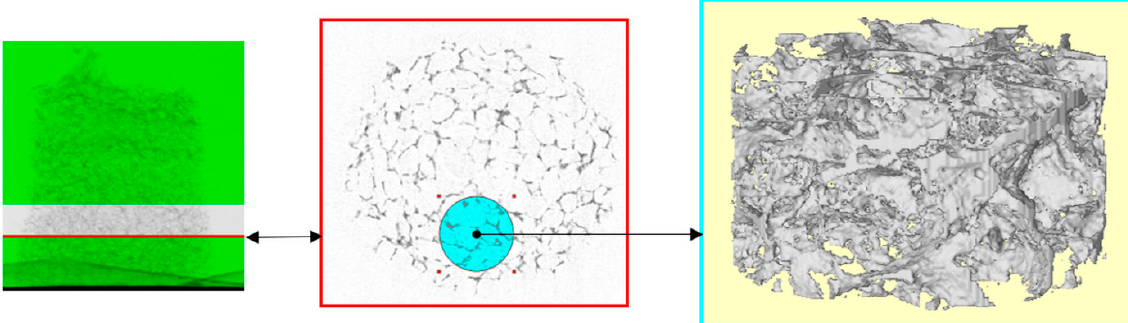
Figure 2. Graphical representation of the ROI—circular cyan area on a slice of the SSF sample and the corresponding 3D Micro-CT model of the reconstructed volume from the selected ROI.